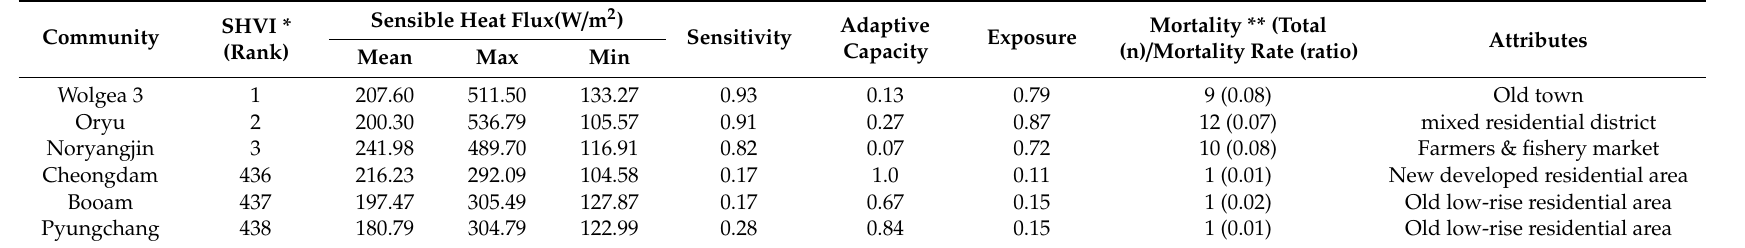
Table 5. Top three-rank and bottom three-rank to sensible heat vulnerability